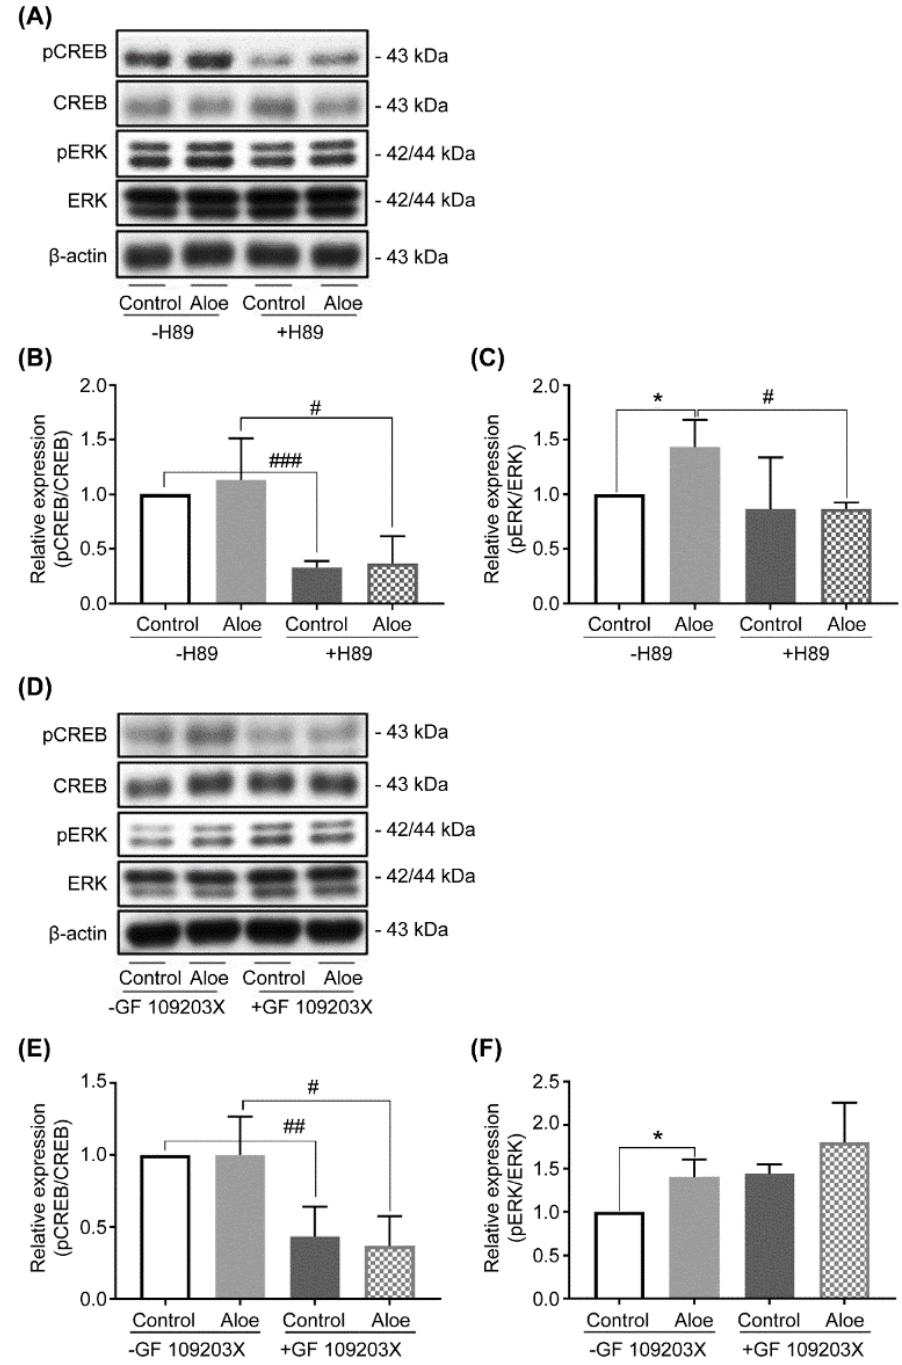
Figure 5. Suppression of Aloe (AV) protein level by PKA inhibitor H89. ( A ) Cells were treated with PKA inhibitor (H89) and 10 µ g/mL AV in 5H media conditions and measured protein expression of phosphorylated ERK and CREB. ( B , C ) Densitometric analysis of pCREB and pERK. ( D ) Cells were treated with PKC inhibitor (GF 109203X) and 10 μ g/mL AV in 5H media conditions and measured protein expression of phosphorylated ERK and CREB. ( E , F ) Densitometric analysis of pCREB and pERK. Data were represented as means ± SD ( n = 3); * p < 0.05, # p < 0.05, ## p < 0.01, ### p < 0.001.